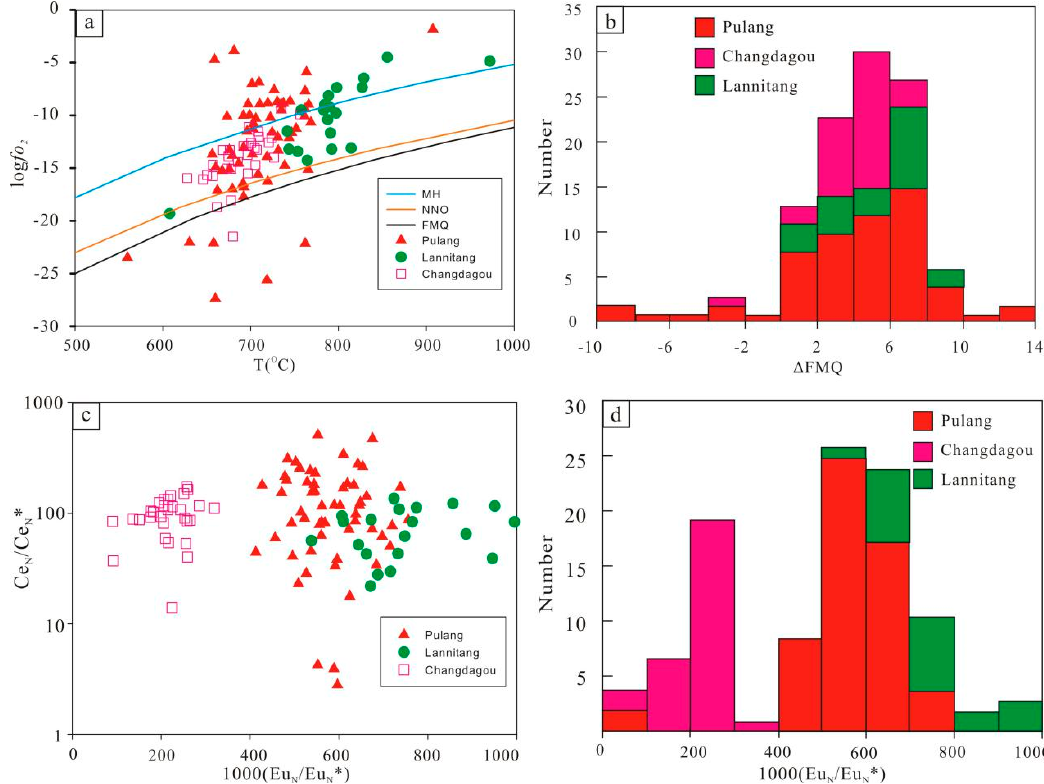
Figure 6. Ce N /Ce N *-related binary diagrams of zircon grains for the Changdagou, Pulang and Lannitang granites from Yidun arc. ( a ) log f O 2 vs. temp. °C diagram, where log f O 2 value was calculated by the method of Trail et al. [34]; ( b ) Histogram of oxygen fugacity; ( c ) Ce N /Ce N * vs. Eu N /Eu N * plot, where Ce N * is calculated by fitting method; ( d ) Histogram of 1000 (Eu N /Eu N *) vs. Data are as listed in